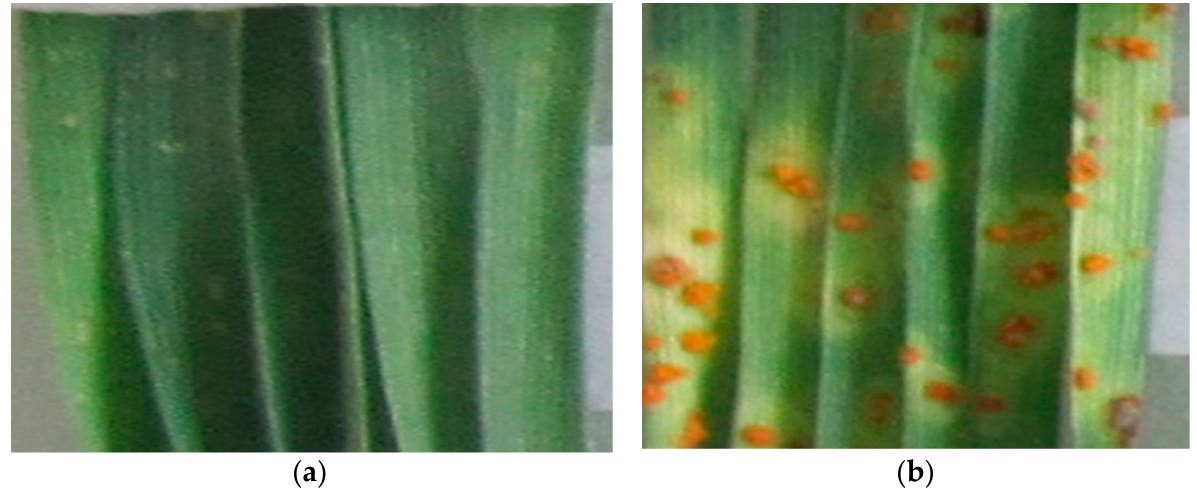
Figure 1. Reaction of cv. Chelyaba 75 ( a ) and line Tc Lr35 ( b ) to leaf rust at the seedling stage. Along with the Sr39 (cid:54) = 22r marker, the S13-R16 marker of the Lr66 gene (= LrS13 ) was also detected in cv. Chelyaba 75. The source of the Lr66 gene is an introgressive line S13 (W84-17//CS7*/ Ae. speltoides ). Homoeologous group 3 chromosomes microsatellite analyses revealed that the S13 introgressed region in line 8029 occurs on chromosome 3A, and it possibly includes the complete 3AS arm (3Ap) and a proximal region of the long arm (q arm) [17]. Since the localization of the LrS13 gene differs from that the resistance gene in cv. Chelyaba 75 ( LrSp ), it can be assumed that they are not